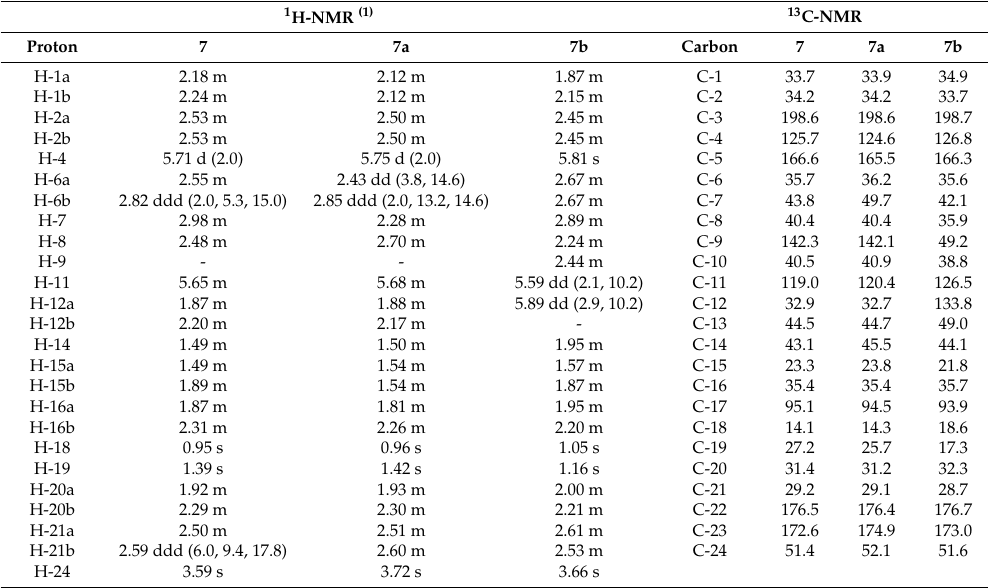
Table 4. The 1 H- and 13 C-NMR spectral data for esters (7 α ,17 α )-9(11)-ene 7 , (7 β ,17 α )-9(11)-ene 7a and (7 α ,17 α )-11-ene 7b .